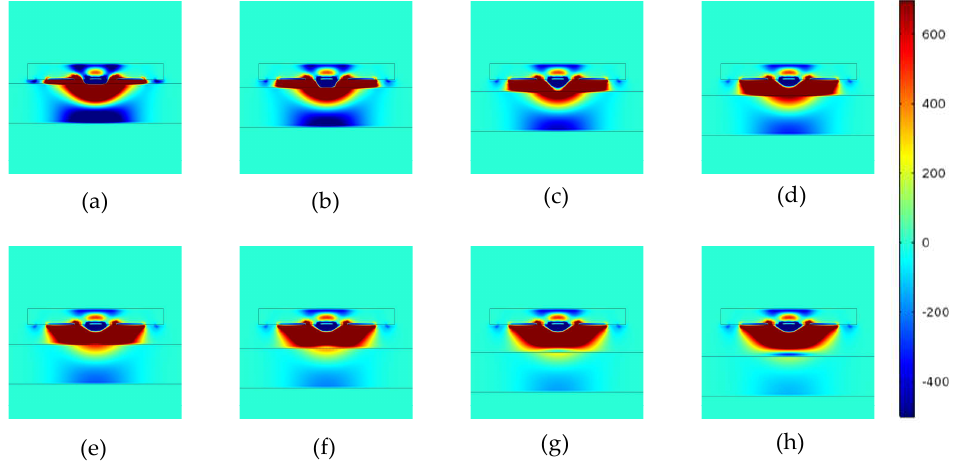
Figure 8. MSD variations with increased lift-offs for a conducting specimen covered by an insulation layer. MSDs at ( a ) 0.5 mm, ( b ) 1 mm, ( c ) 1.5 mm, ( d ) 2.0 mm, ( e ) 2.5 mm, ( f ) 3.0 mm, ( g ) 3.5 mm, and ( h ) 4.0 mm lift-offs.